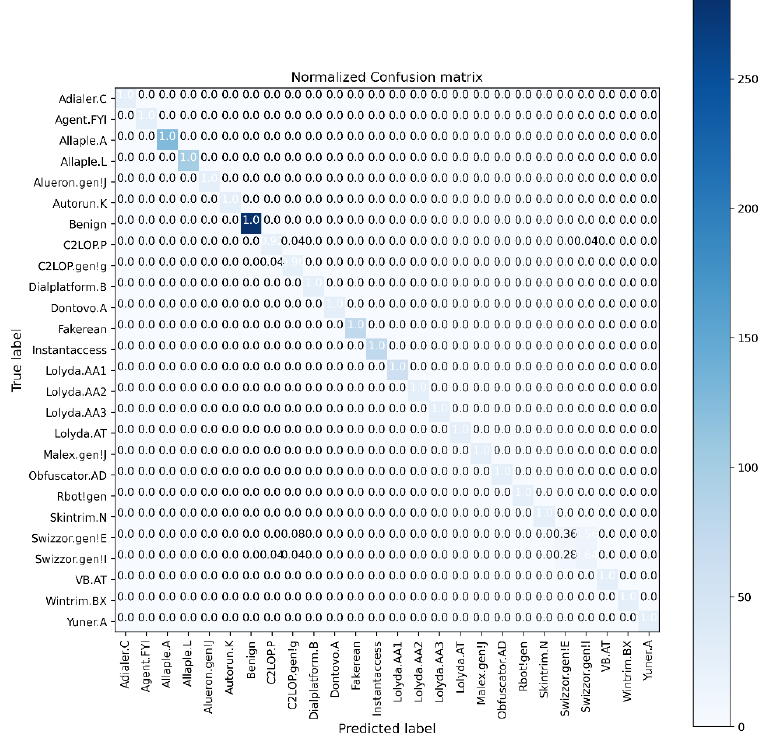
Figure 11. Normalized confusion matrix for classification of 25 malware classes.